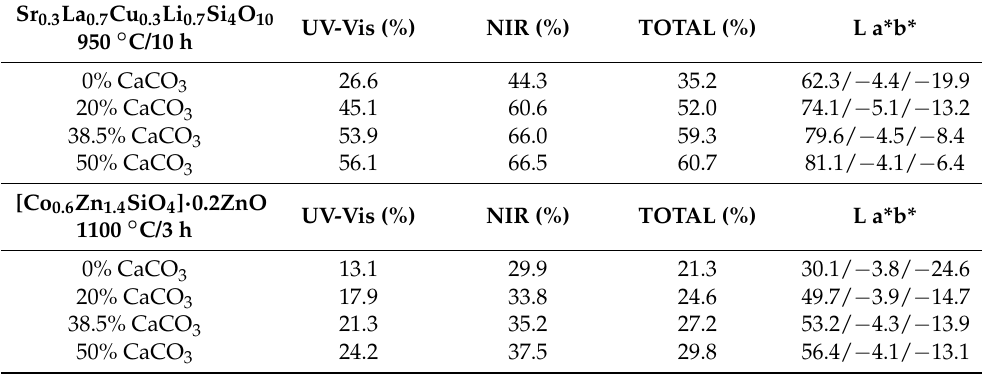
Table 2. Colorimetry and reflectance parameter for CaCO 3 addition to blue pigments.